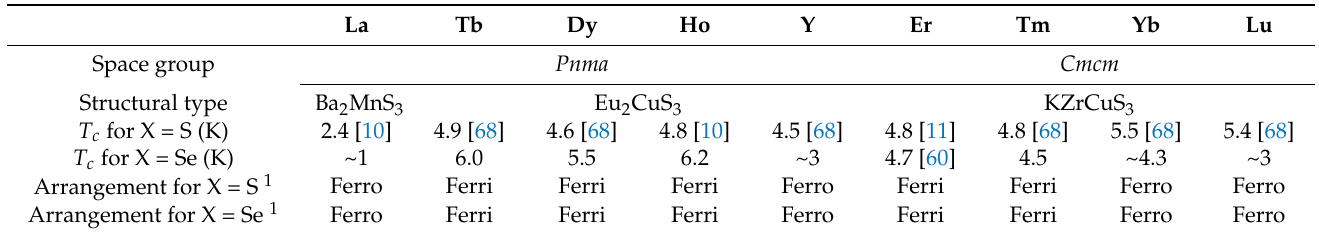
Table 5. Comparison of the magnetic characteristics for EuLnCuX 3 (Ln = La, Tb, Dy, Ho, Y, Er, Tm, Yb, Lu; X = S,